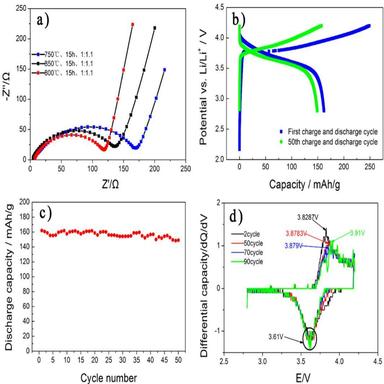
(a) Alternating current impedance analysis. (b) Charge and discharge curves. (c) Cycle number-specific capacity curve. (d) dQ/dV curve analysis.